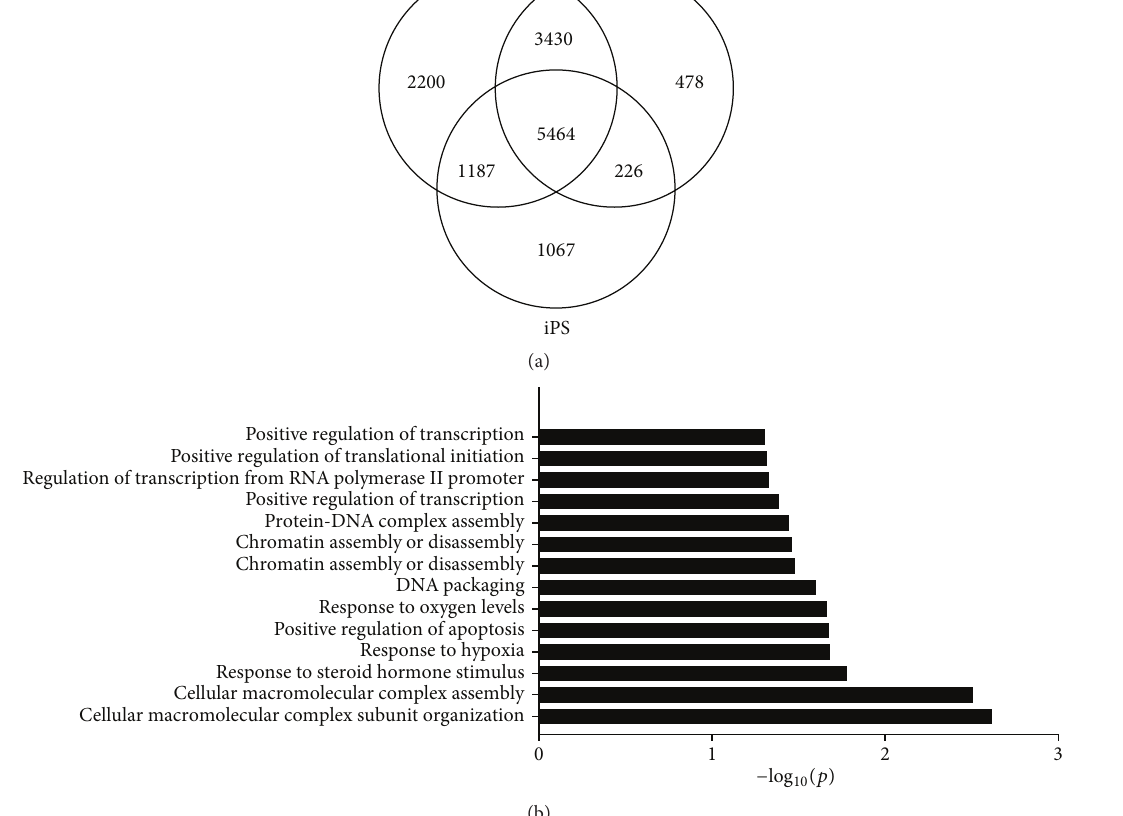
Figure 6: Distribution of H2A.Z during reprogramming and special functions of H2A.Z in Day 7 cells. (a) Venn diagram depiction of the number of genes occupied with H2A.Z in different cell samples. (b) Biological processes involved with the special genes occupied with H2A.Z in Day 7